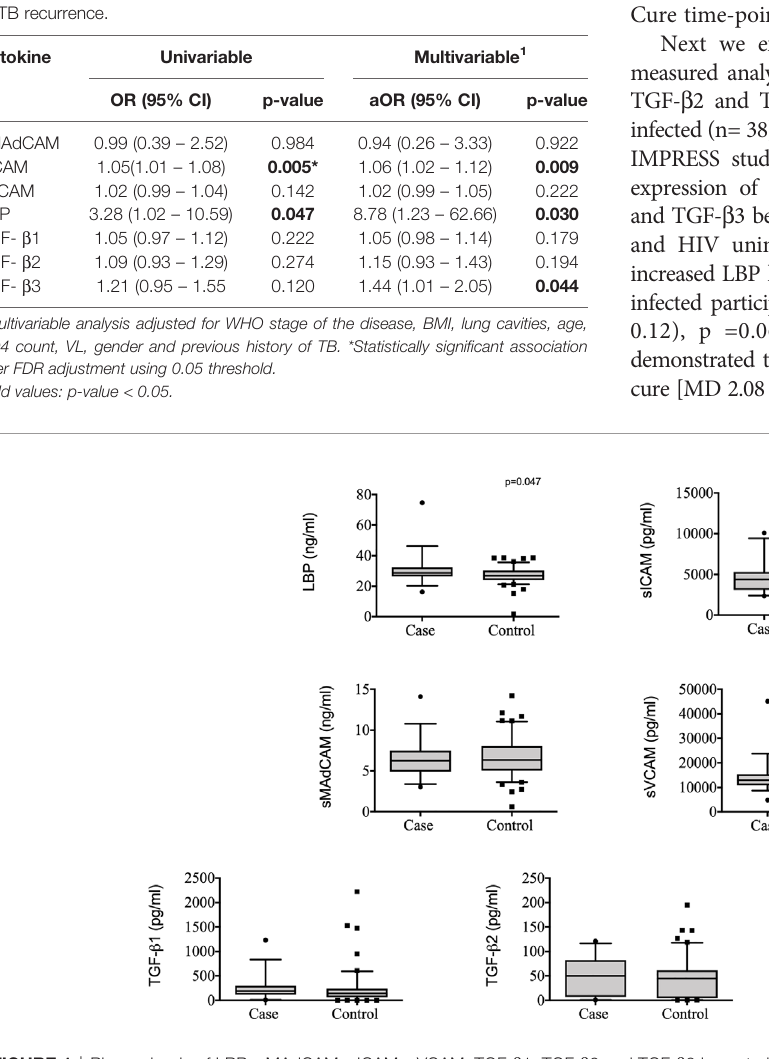
FIGURE 1 | Plasma levels of LBP, sMAdCAM, sICAM, sVCAM, TGF- b 1, TGF- b 2 and TGF- b 3 in controls (n = 103) and cases (n = 37) from TRuTH. Analytes were plotted using Box and Whiskers (5-95%). P-values indicated in the fi gures are the result of univariable conditional logistic regression (please refer to Table 1 for full